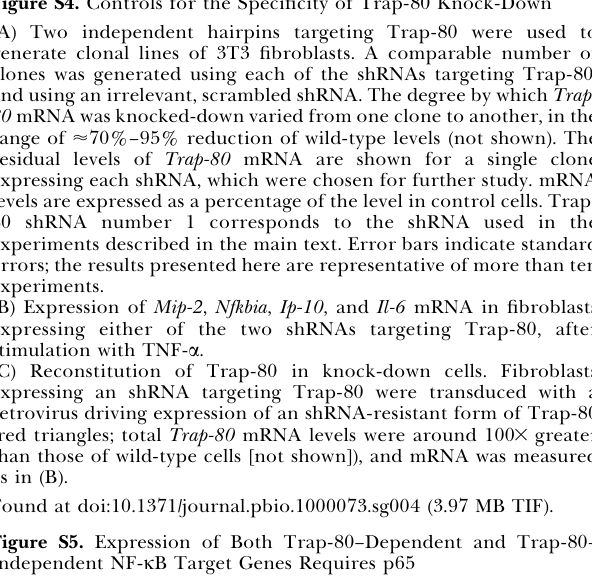
Figure S3. Expression Levels of Trap-95-Biotin Figure S4. Controls for the Specificity of Trap-80 Knock-Down Figure S7. Trap-80–Dependent and –Independent Genes Figure S8. Presence of HA-Trap-80 at Promoter Regions